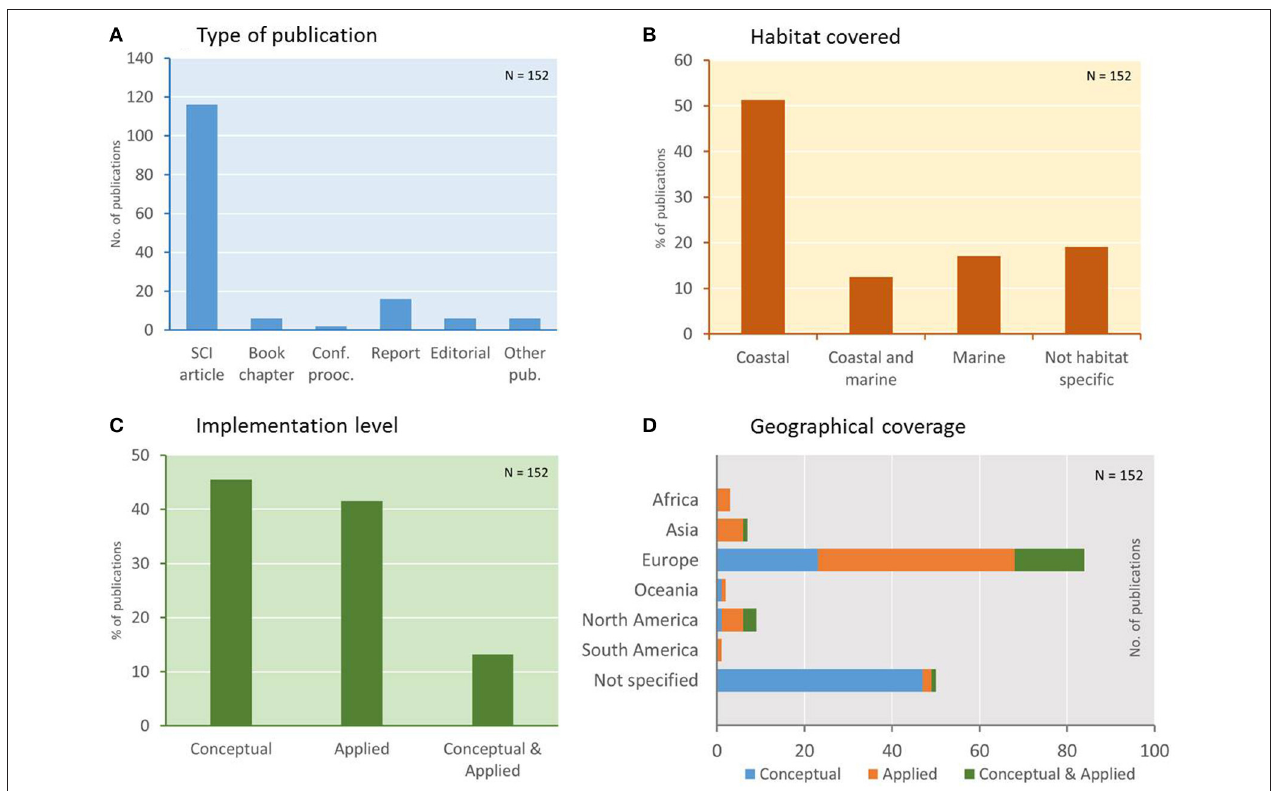
FIGURE 2 | (A) Types of publication; (B) Habitats covered; (C) Implementation level; and (D) geographical